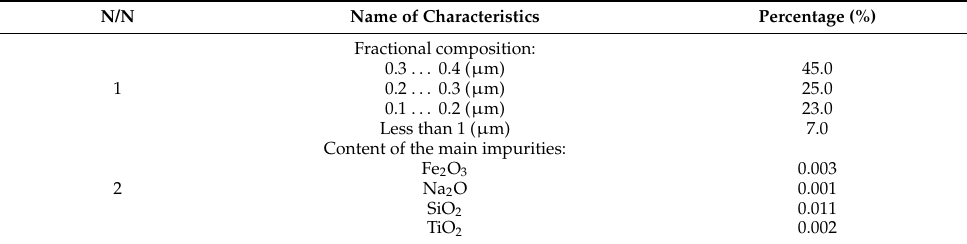
Table 2. Characteristics of α -Al 2 O 3